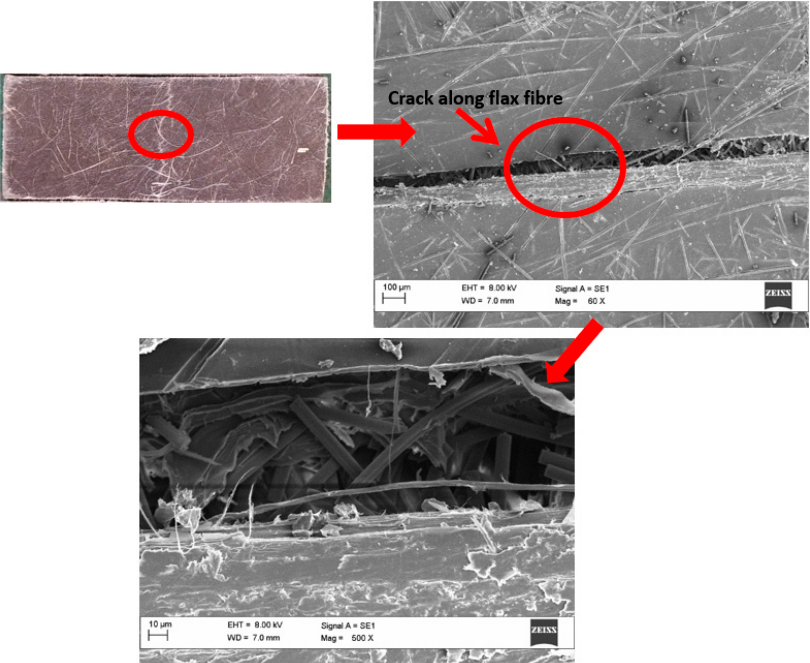
Figure 9. SEM images of the matrix crack of specimen 3-3 in 60× and 500× magnification. The crack propagated along the flax-fibre-PLA interface.